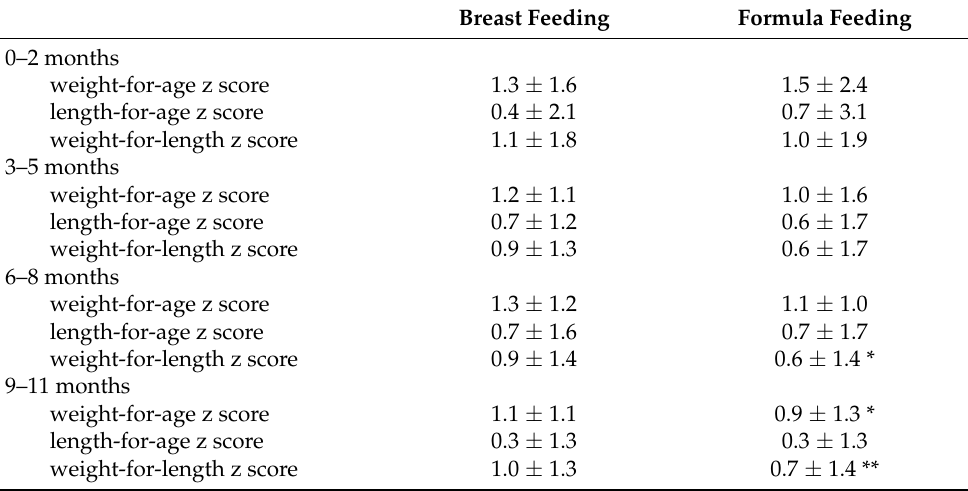
Table 2. Infant physical development in breastfeeding and formula feeding group after matching. Breast Feeding Formula Feeding